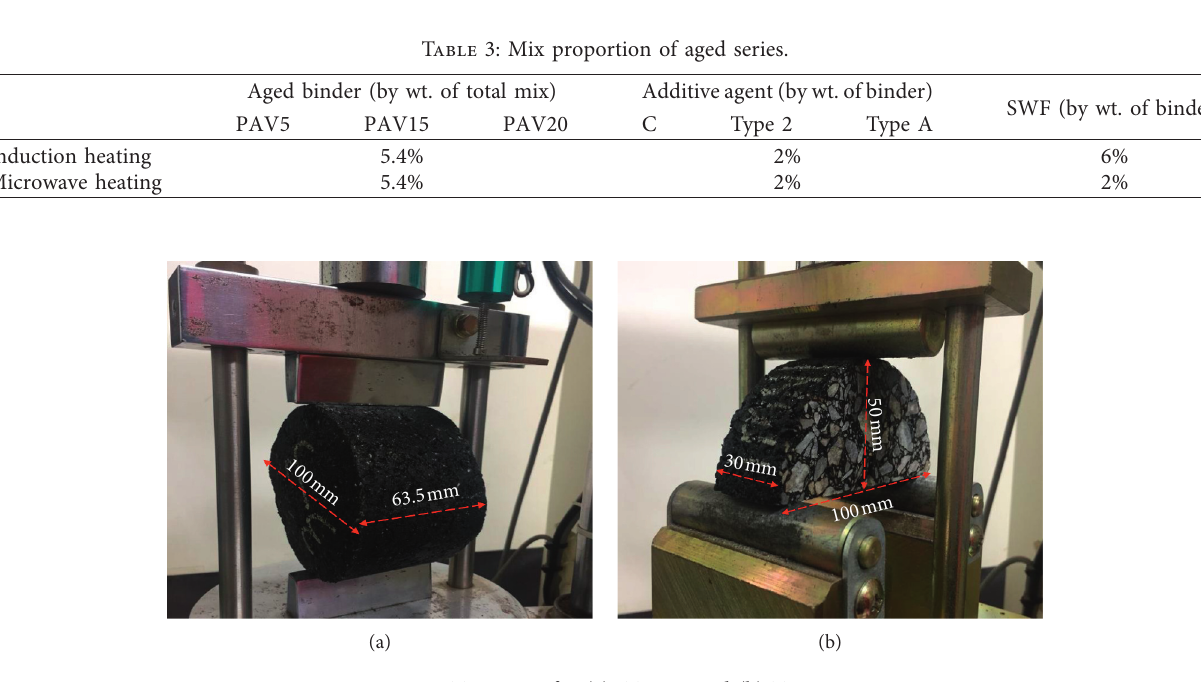
Figure 2: Test setup for (a) ITS test and (b) TPB test.